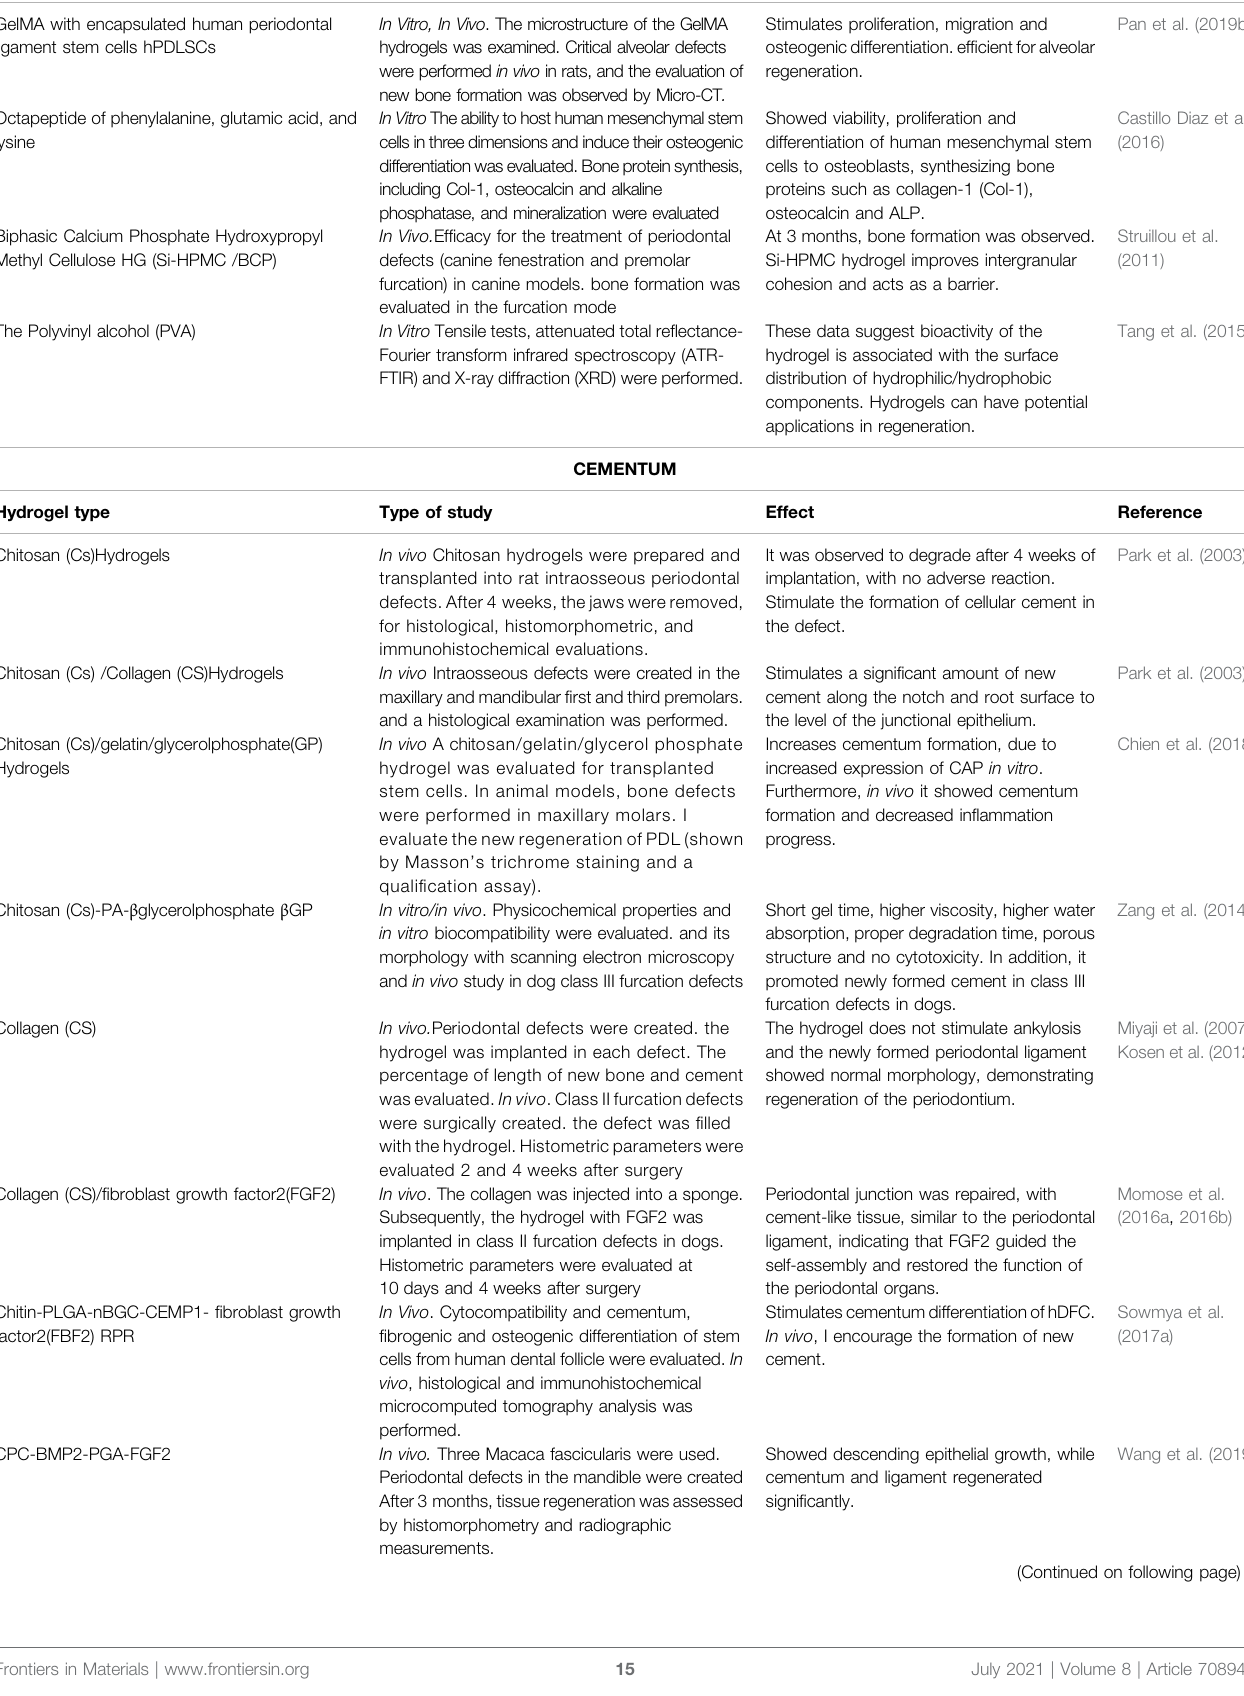
TABLE 2 | ( Continued ) Hydrogel-based scaffolds for periodontal tissue